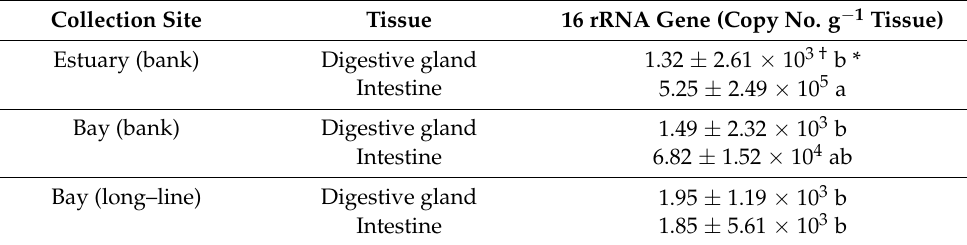
Table 1. The abundance of total bacteria in the digestive gland and intestine tissues of Choromytilus chorus grown in estuary water (Nehuentue) and bay seawater (Hueihue). as revealed by quantitative PCR using 16S rRNA gene as a